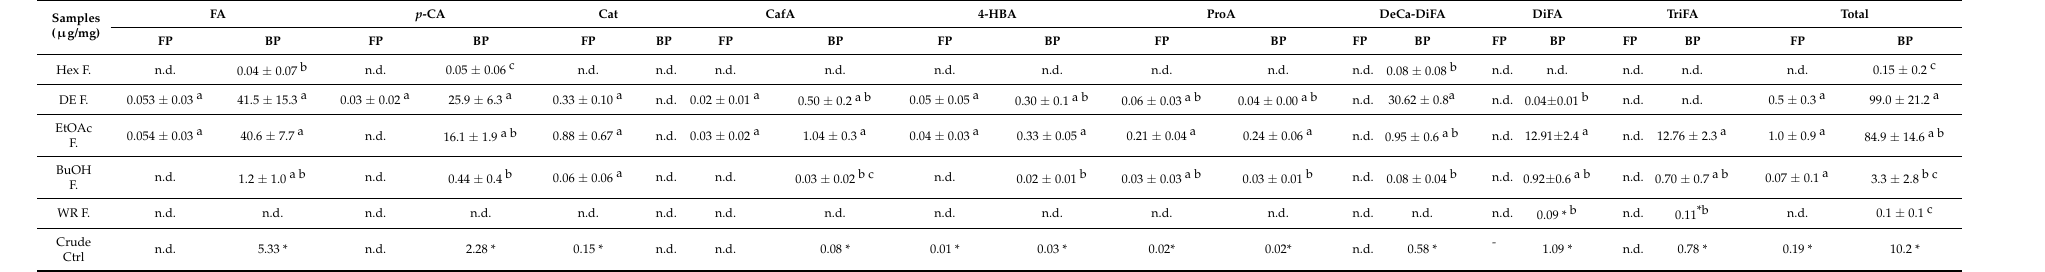
Table 2. Individual polyphenols quantified by UPLC-MS/MS in microgram/milligram ( µ g/mg) BSG